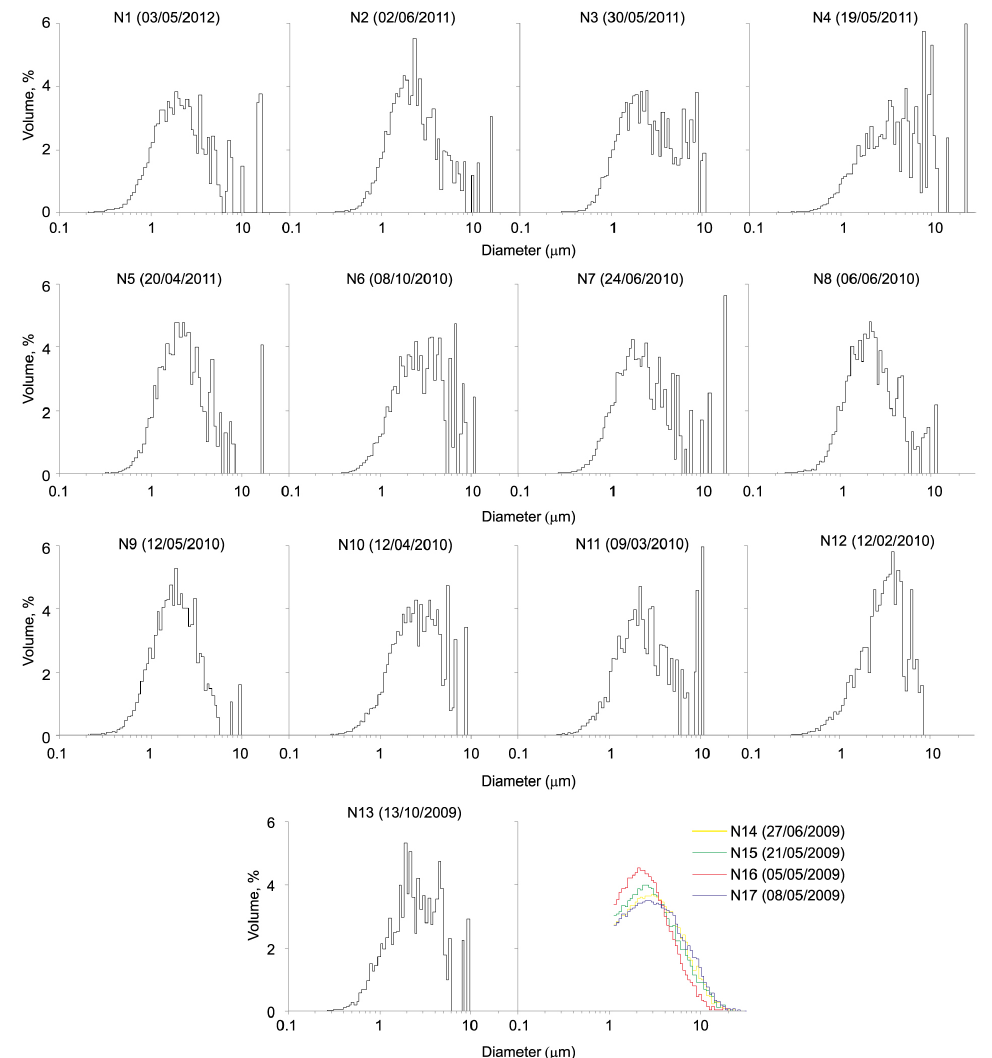
Fig. 9. Particle size distributions by volume for dust deposition events recorded between 2010 and 2012 and analysed using SEM. Particle size distributions for the 2009 events analysed using CCM are shown for